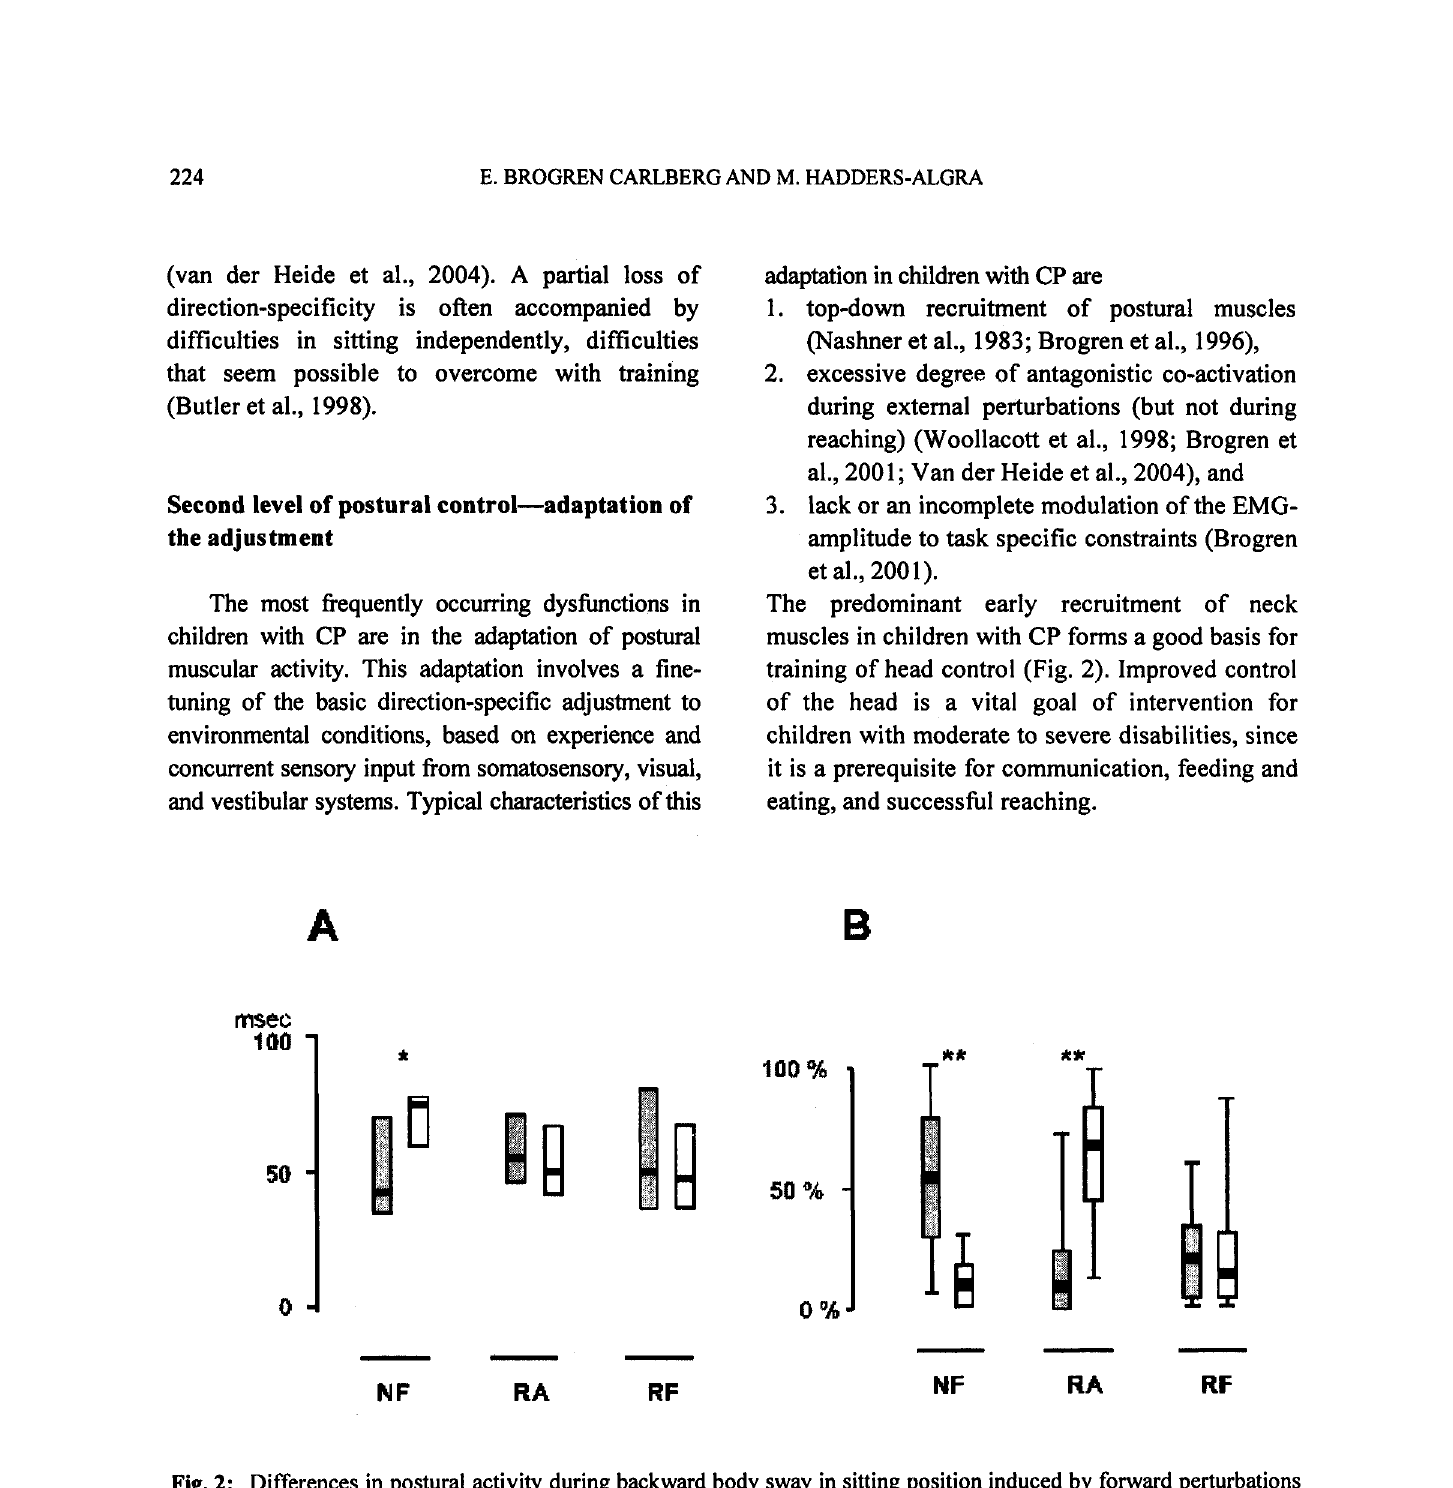
Fig. 2: Differences in postural activity during backward body sway in sitting position induced by forward perturbations from a moving support surface between typically developing children and children with CP. Panel A: latencies (msec) to EMG responses in NF=neck flexors, RA=rectus abdominis, and RF=rectus femoris. Panel B: rate of response (%) during.which a specific muscle started the adjustment. Filled boxes represent children with CP and open boxes represent typically developing children. Boxes indicate 25 th and 75 th centiles, vertical bars the total range, and black horizontal bars denote the median value. Asterisks indicate statistically significant differences * p<0.05, ** p<0.01 (Wilcoxon). (Adapted from Brogren et al., 1996 and Brogren et ai.,